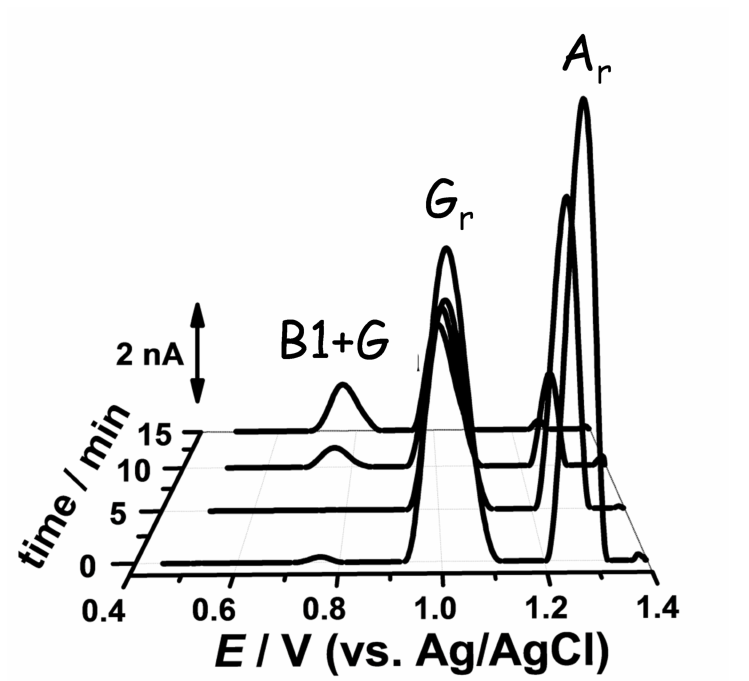
Figure 9. Baseline-corrected DPV at pH 4.5, with a dsDNA electrochemical biosensor incubated in 500 µ g mL − 1 bevacizumab for different time periods. Adapted from [102] with